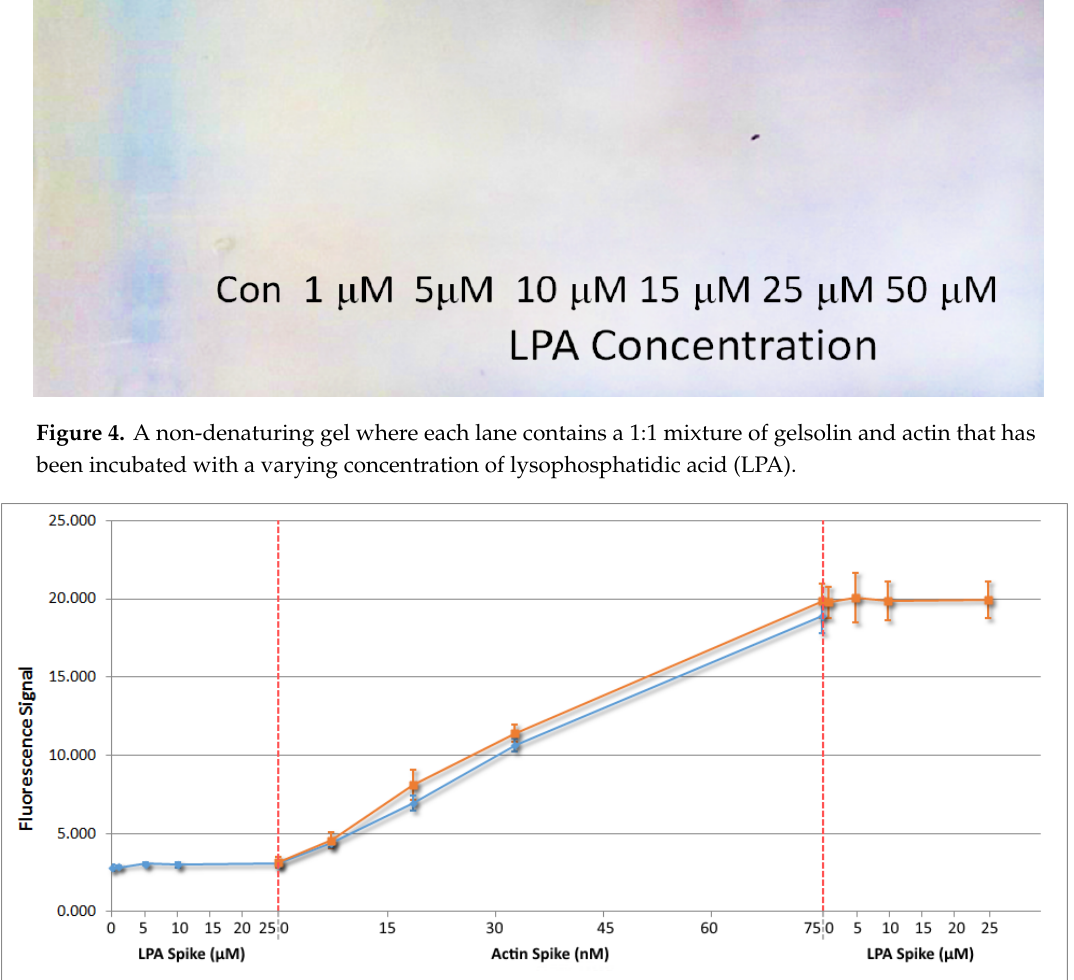
Figure 5. Fluorescence analysis of rhodamine-dyed actin in serum where in orange actin was first added to serum at the specified concentrations followed by the addition of LPA to the final serum solution, and in blue LPA was added to serum at the specified concentrations followed by the addition of actin to the final solution.